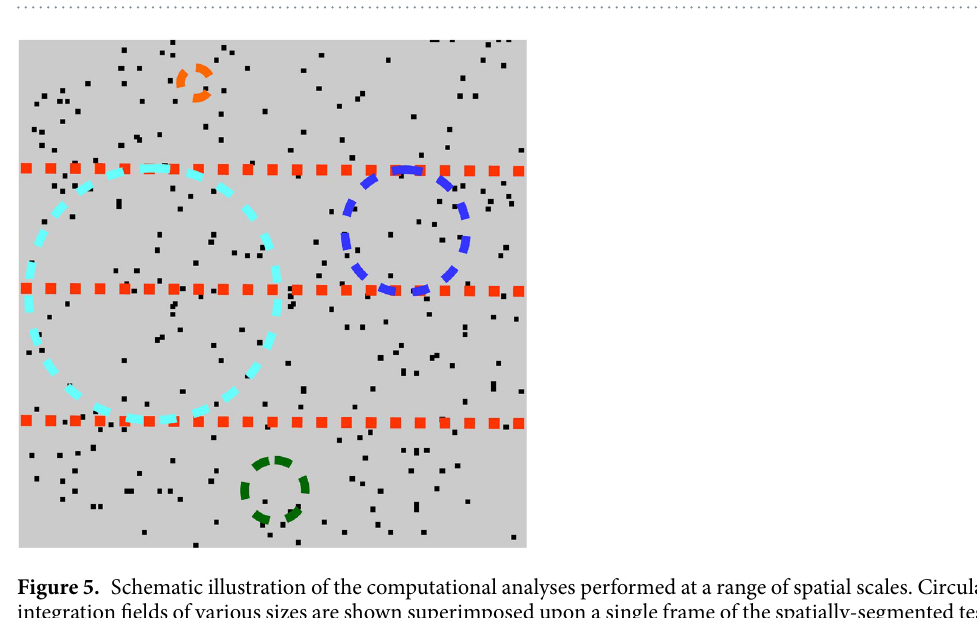
Figure 4. Same as Fig. 3 except the scatterplots show results for the form task.